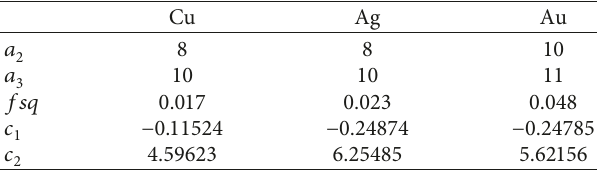
Table 1: Coefficients of the new potential energy surface and calculated macroscopic